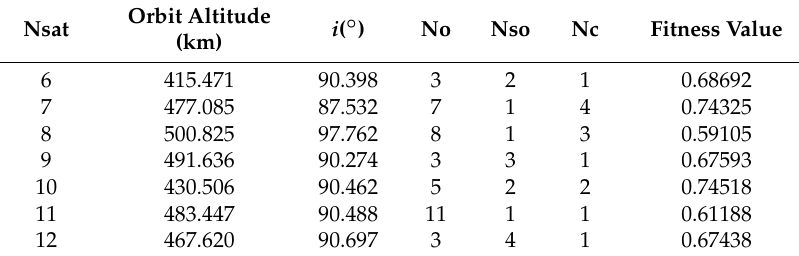
Table 4. The parameters of the optimal 2D-LFC configurations.